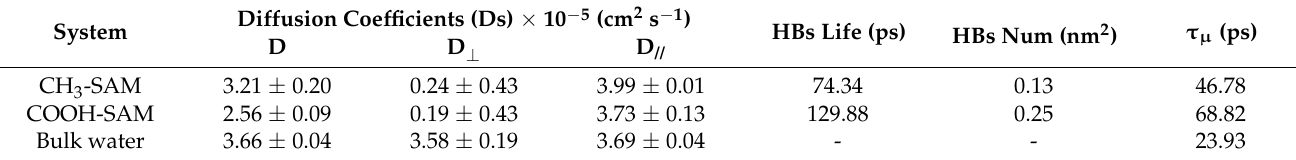
Table 2. Some property parameters of solvent layer molecules on the substrate surface. System